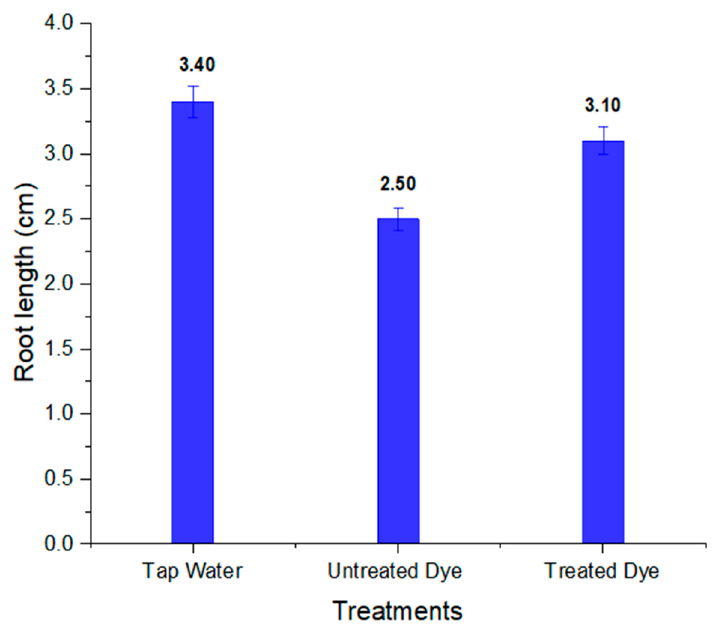
Figure 16. Root length of Vigna radiata in tap water and in untreated and treated orange II dye.